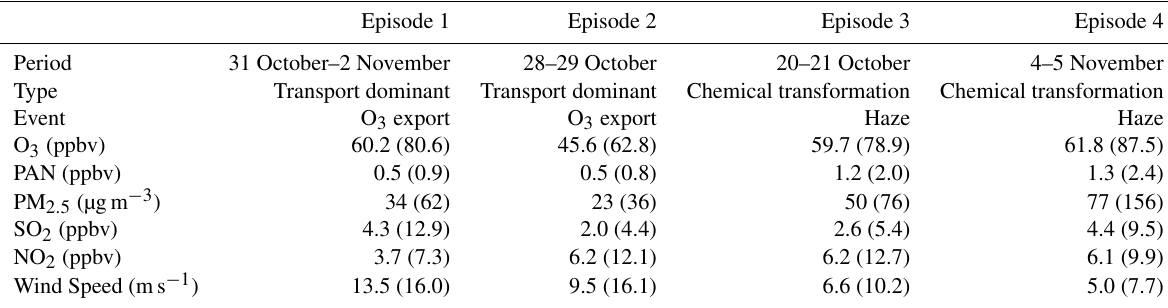
Table 1. Chemical and meteorological characteristics of the four episodes.